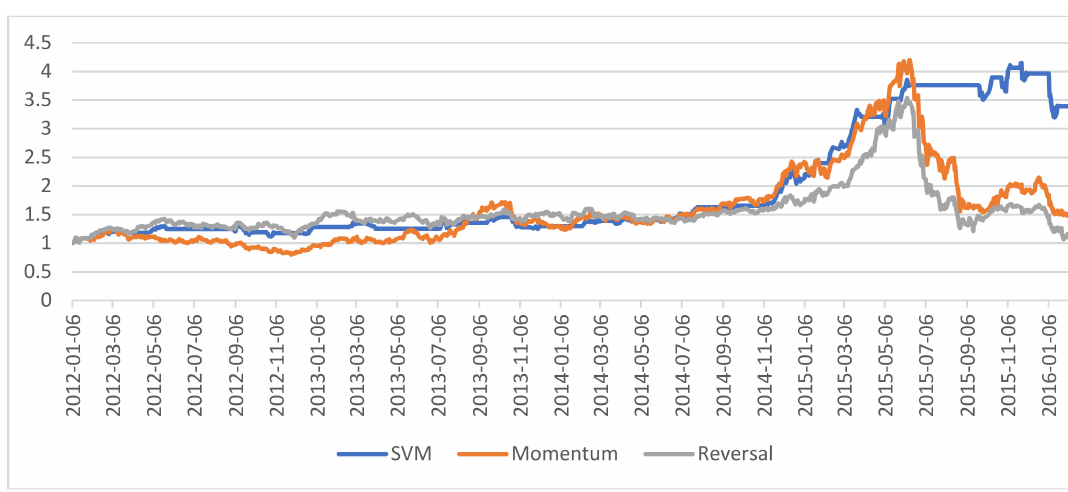
Figure 5. Portfolio performance comparison for the DT.